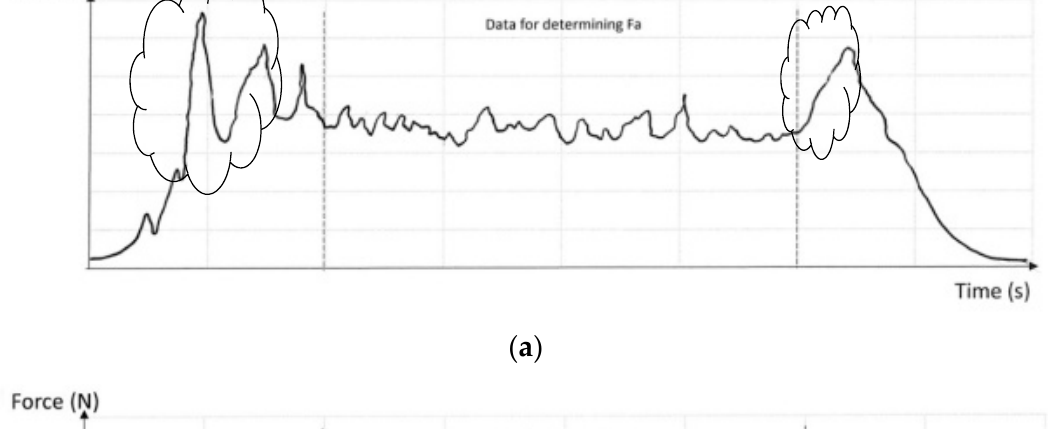
Figure 5. Criteria for calculating Fa: ( a ) Goh [15]; ( b ) ANSI/ASSP Z359.13 [17] (clause 4.1.10).